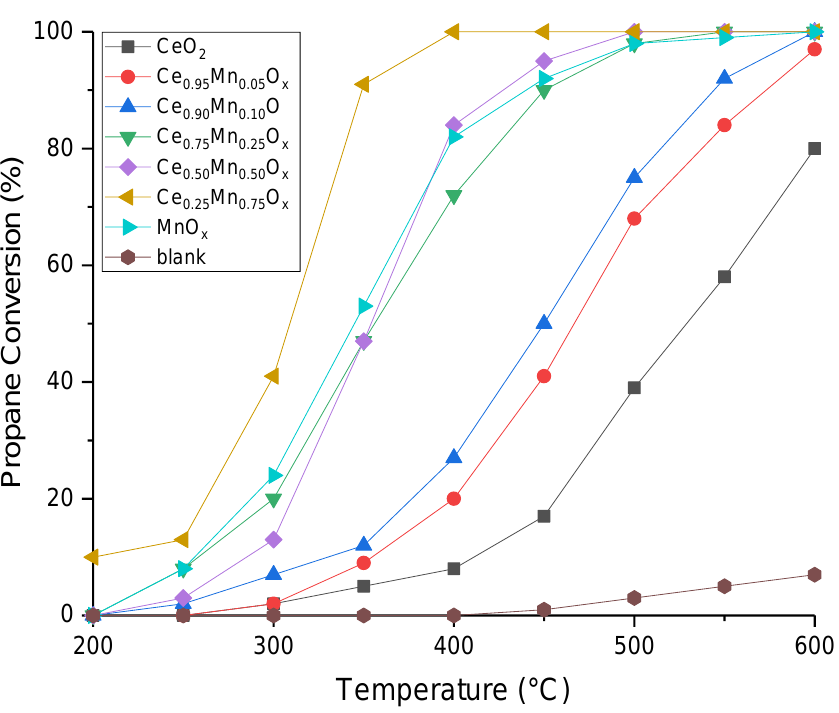
Figure 1. Propane conversion as a function of temperature for cerium-manganese mixed metal oxide catalysts prepared by sodium carbonate co-precipitation. Reaction conditions: 5000 ppm propane in air, Gas Hourly Space Velocity (GHSV) = 45,000 h − 1 , Temperature range = 200 –600 °C. All ratios of the mixed metal oxides, along with the pure manganese oxide catalyst, were more active than the ceria catalyst, which did not fully convert the propane over the temperature range studied. A similar observation was made by Ren et al. [39] as at 600 ° C, only 80% propane conversion was achieved. The activity for the manganese oxide was higher than the ceria, with full conversion of propane achieved by 500 ° C, this agrees with work in the literature where MnO x was more active than CeO 2 for the total oxidation of VOCs such as ethanol, ethyl acetate, toluene, and propane [29,39]. The addition of manganese to ceria led to an increase in activity in all instances. All